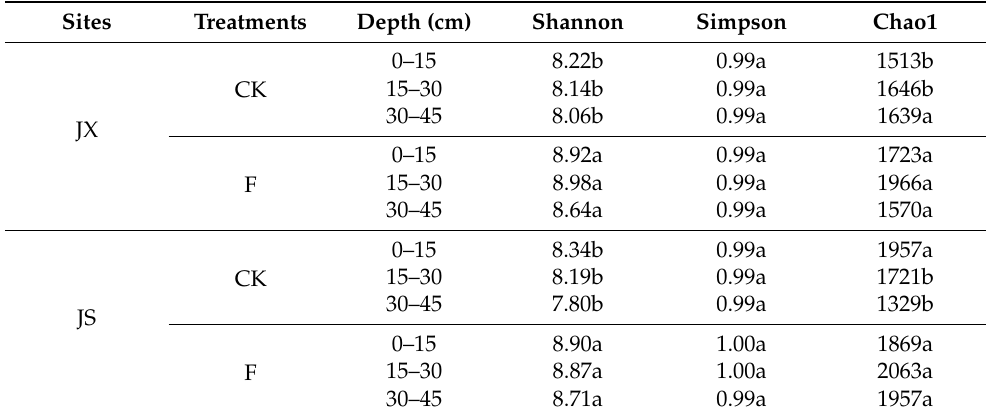
Table 2. Shannon, Simpson and Chao1 indexes of soil bacteria in different T . Zhongshanshan plantations with increased age.